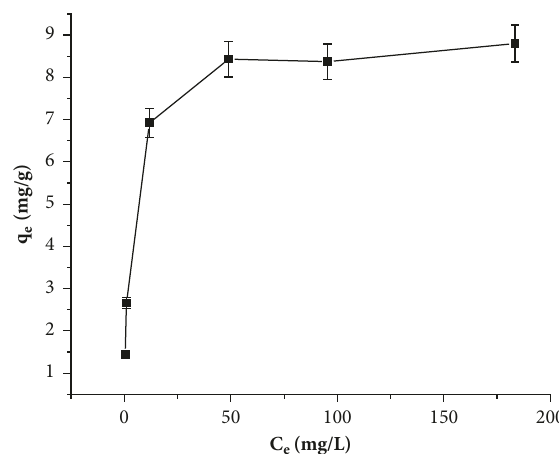
Figure 3: Adsorption isotherm of Mg 2+ ions onto CTNTs scaffolds as measured at pH 7.2 after 24 h.